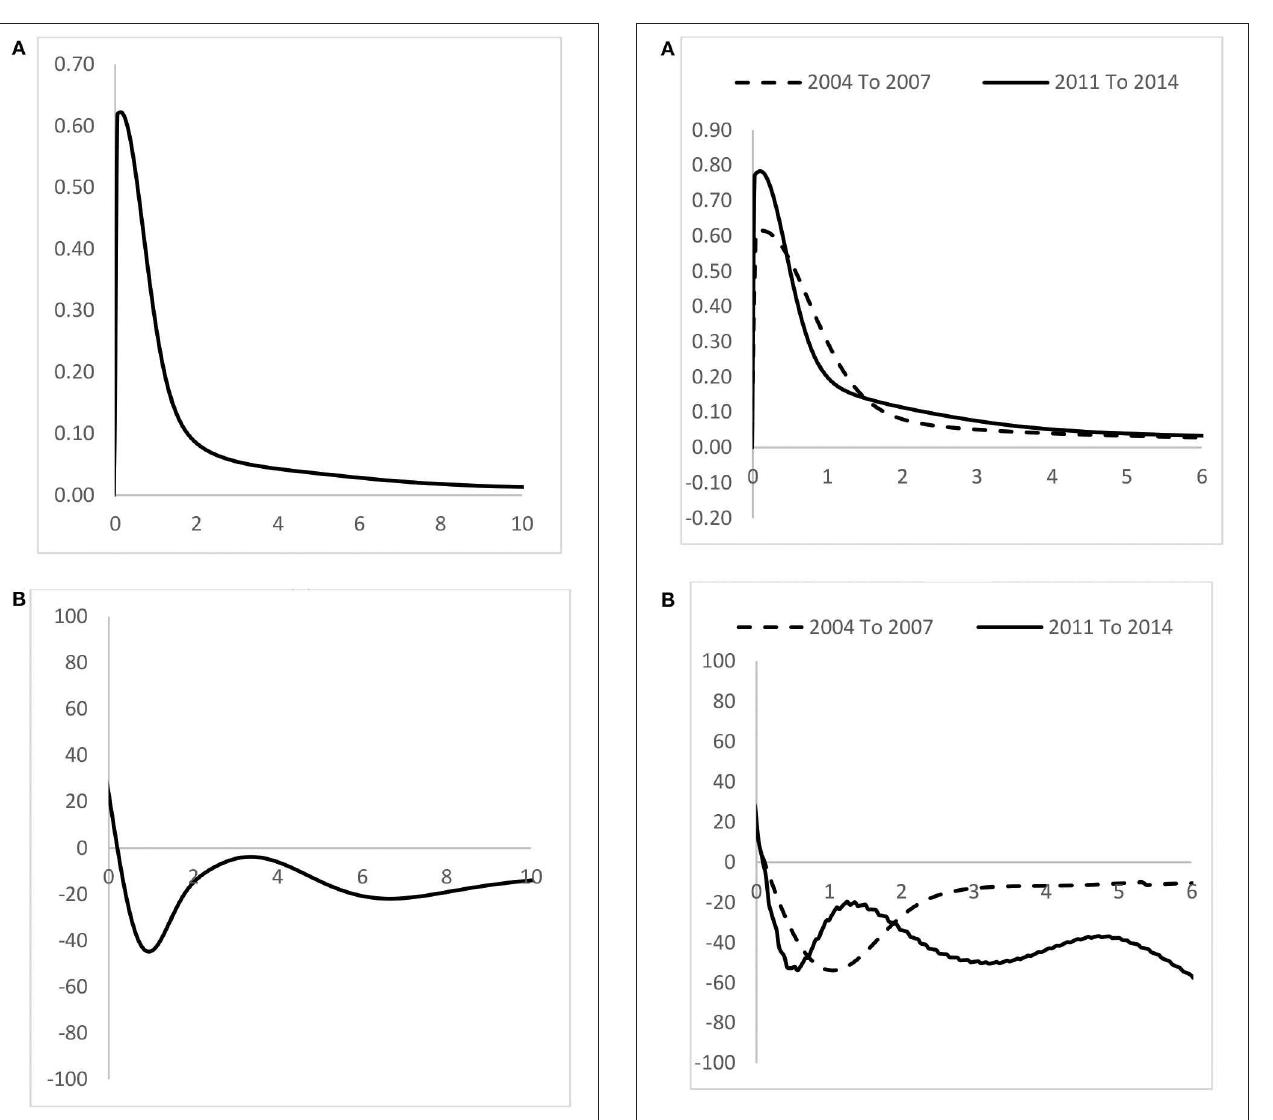
FIGURE 3 | Ergodic distribution and MPP of the coal market for all countries. Note: For (A) , horizontal axis represents relative per capita consumption, vertical axis represents proportion. For (B) , horizontal axis represents relative per capita consumption, vertical axis represents MPP. Source: Authors’ calculation.